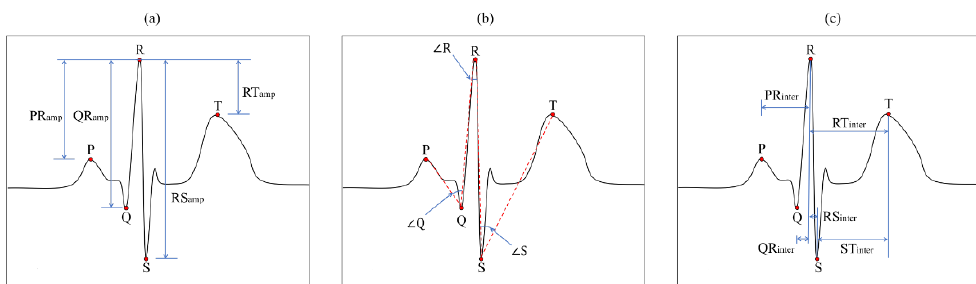
Figure 8. ECG features for the authentication: four amplitudes ( a ), three angles ( b ), and six temporal features ( c ) including RR interval.